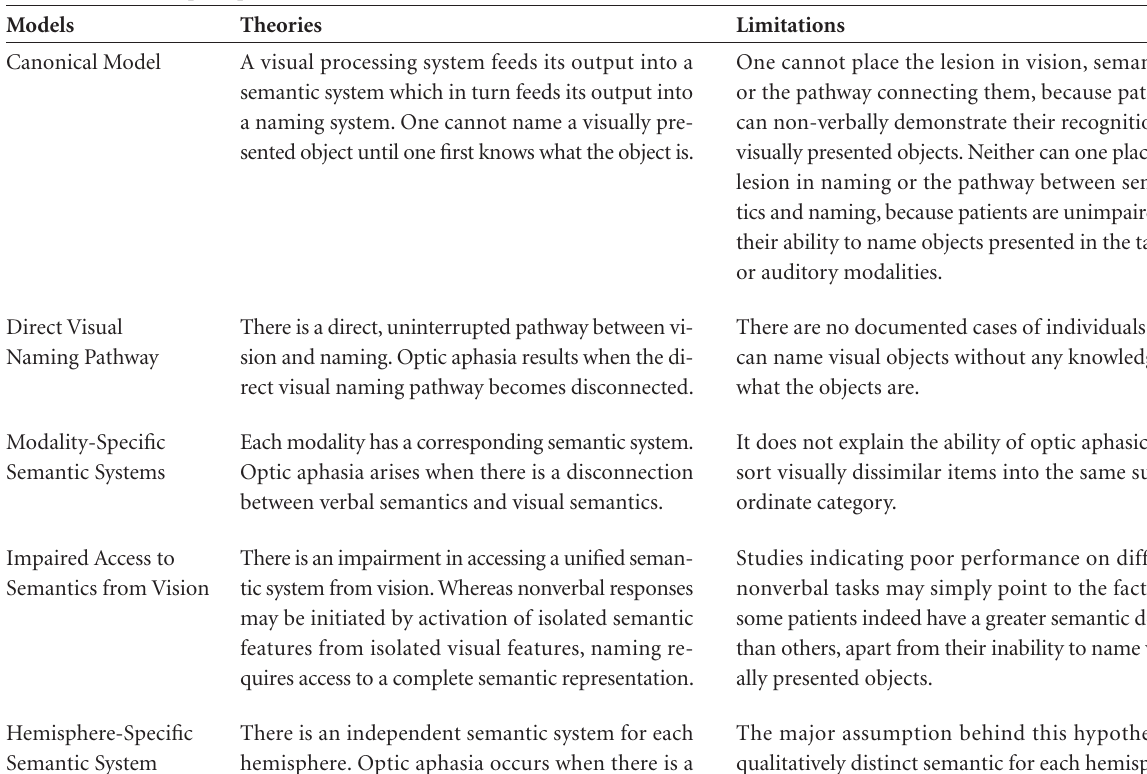
Table 2. Models of optic aphasia 2